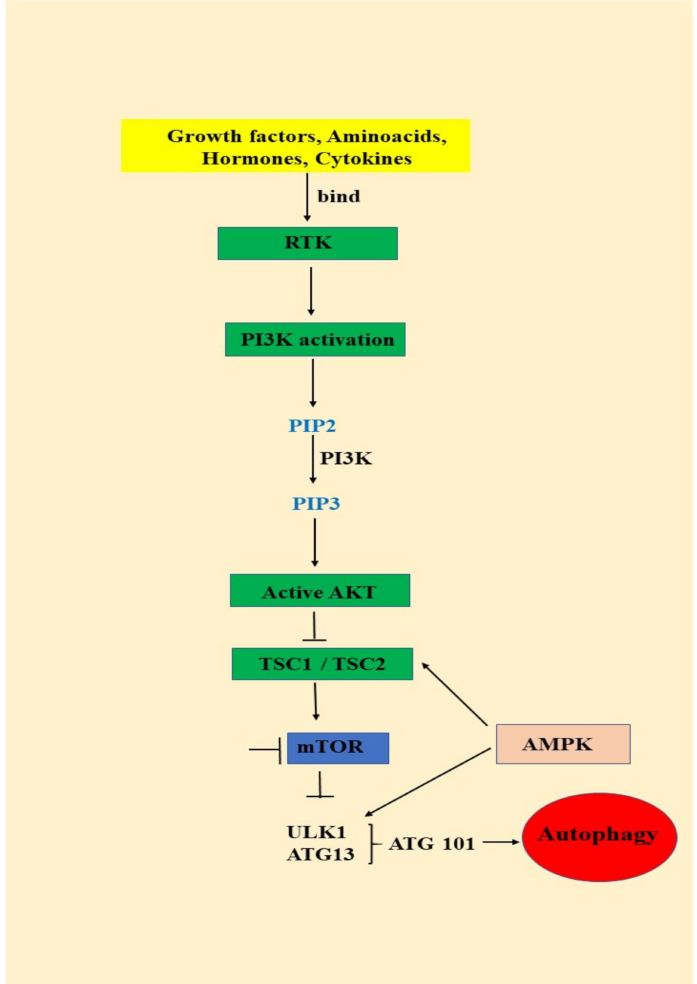
Figure 1. The relationship between the PI3K / AKT / mTOR signaling pathway and autophagy: RTK (receptor tyrosine kinase); PI3K (phosphatidylinositol 3-kinase); PTEN (phosphate and tensin homology); AKT (serine / threonine kinase); TSC (tuberous sclerosis complex); mTOR (mammalian target of rapamycin); AMPK (AMP-activated protein kinase); ULK (unc-51 like autophagy activating kinase 1 ); ATG (autophagy-related protein 13); ATG 101 (autophagy-related protein 2